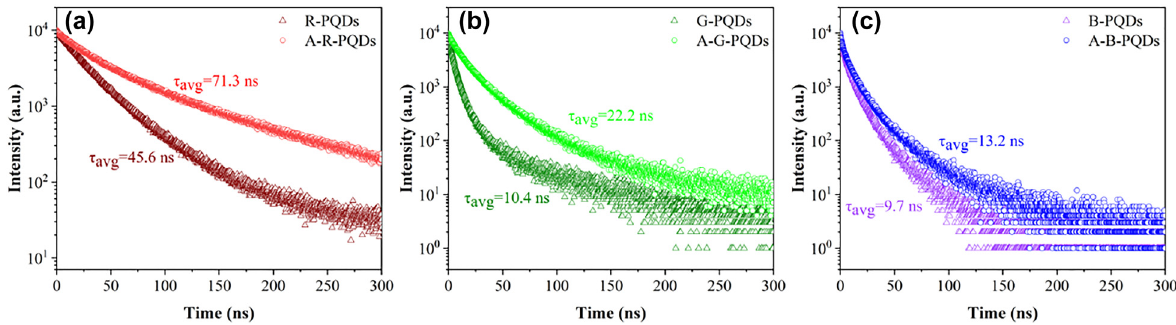
Figure 5: Comparisons of the TRPL between (a) R-PQDs and A-R-PQDs, (b) G-PQDs and A-G-PQDs, and (c) B-PQDs and